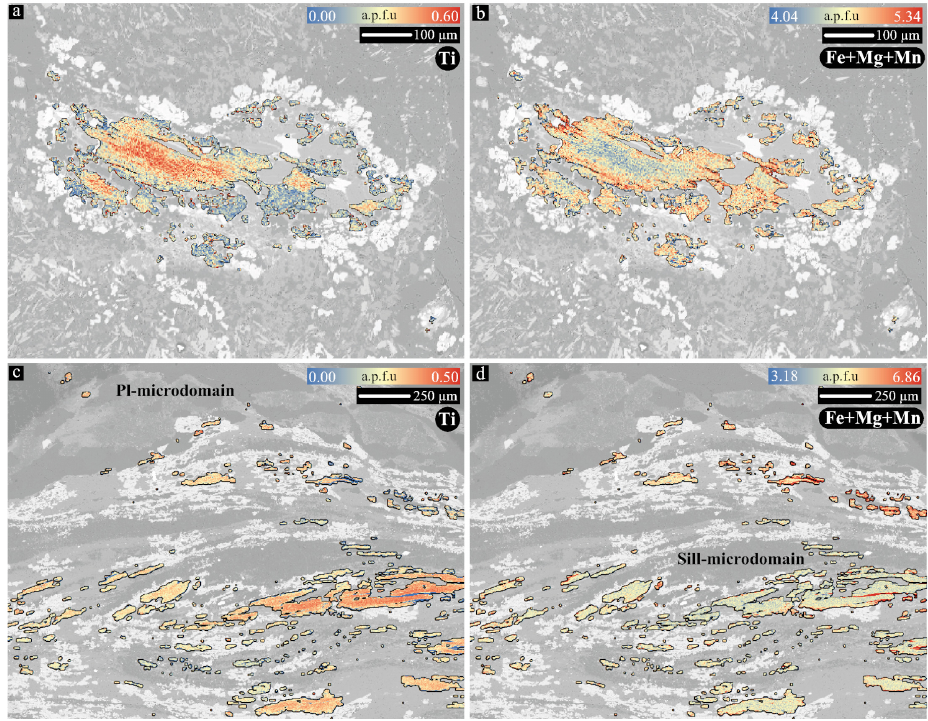
Figure 9. Calibrated maps of biotite: ( a , b ) calibrated maps of Ti and Fe + Mg + Mn of LdV biotite; ( c , d ) calibrated maps of Ti and Fe + Mg + Mn of MM